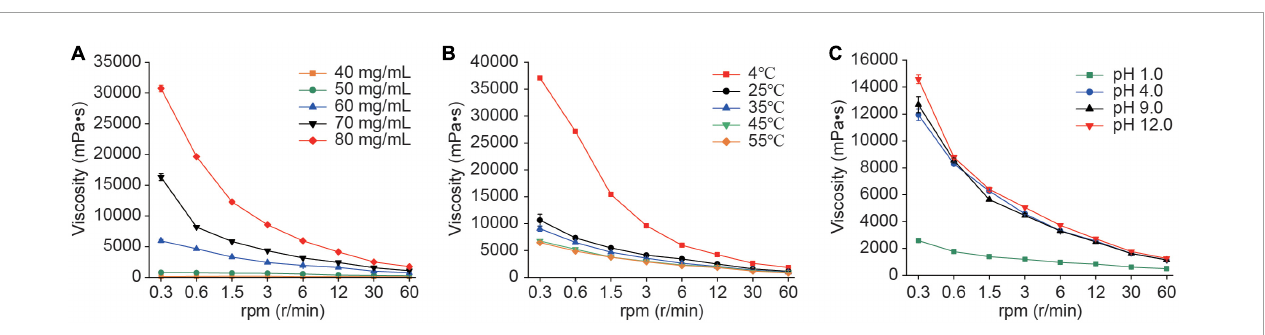
FIGURE8 Rheological behavior of RSG7 dextran at different conditions. (A) Dextran concentrations within the range of 40–80 mg/mL, (B) temperatures of 4, 25, 35, 45, and 55 ◦ C, and (C) pH values of 1.0, 4.0, 9.0, and 12.0. Data represent the mean ± SD of three